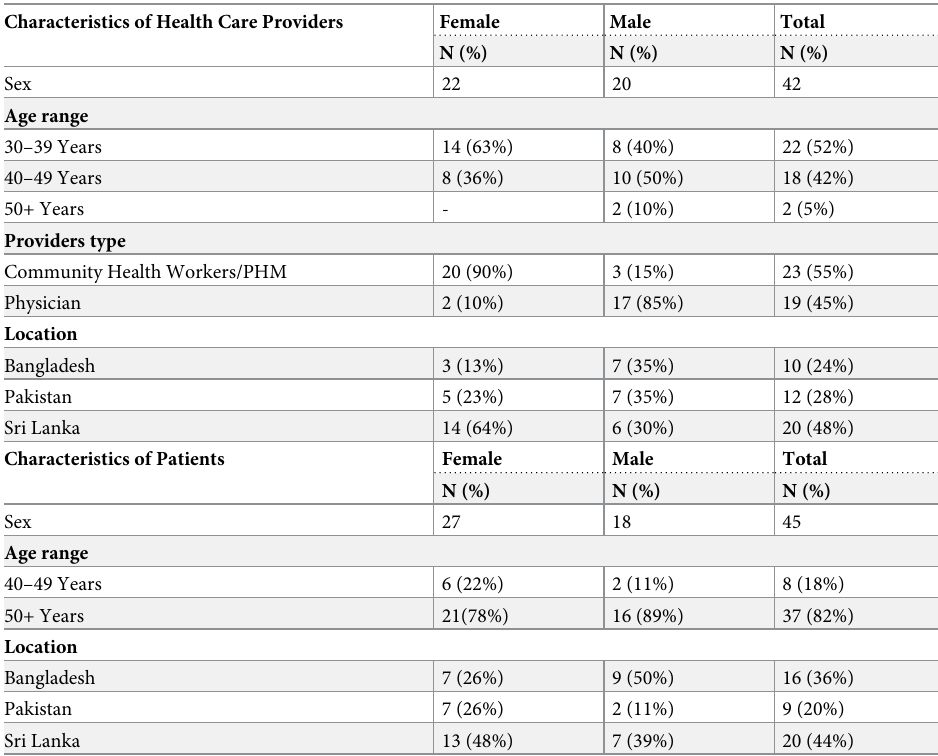
Table 1. Characteristic of